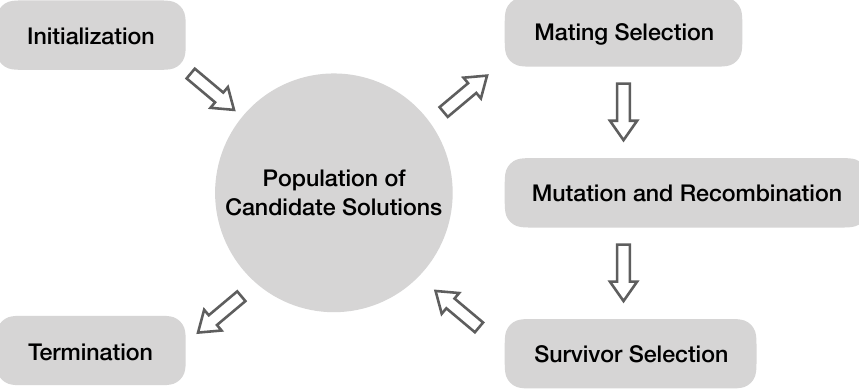
Figure 2. General workflow of an evolutionary algorithm. Typically, a population of candidate solutions to a problem is randomly initialized. Then, through the iterative evolution process, fitter solutions are more likely to be picked for reproduction and survival. Similar to living systems, random changes can be introduced to reproduction, such as mutation and recombination. The algorithm terminates once satisfactory solutions are observed or the computational limit (e.g., the maximal number of generations) has been